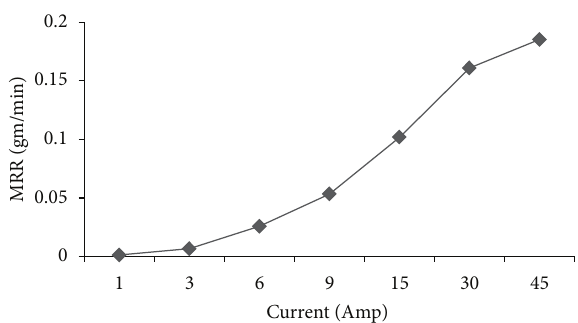
Figure 11: Influence of pulse-off time on MRR at constant current 9 Amp, gap voltage 60V, and pulse-on time 90 𝜇